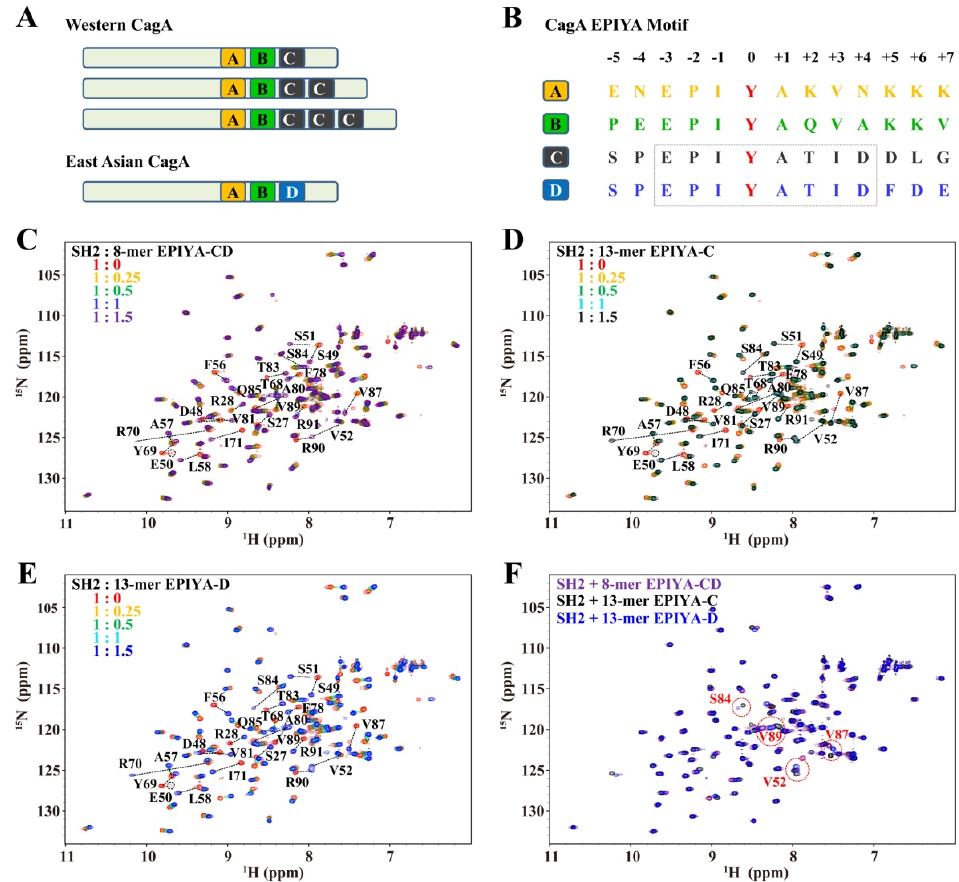
Figure 1. SHIP2-SH2 interacts with Tyr-phosphorylated CagA EPIYA-C and EPIYA-D motifs. ( A ) Domain diagrams of Western and East Asian CagA. ( B ) Amino acid sequences of four EPIYA motifs. The phosphorylated tyrosine is shown in red color. NMR titrations of SHIP2-SH2 by 8-mer Tyr-phosphorylated CagA EPIYA-CD peptide ( C ), 13-mer Tyr-phosphorylated CagA EPIYA-C peptide ( D ) and 13-mer Tyr-phosphorylated CagA EPIYA-D peptide ( E ). The residues with remarkable chemical shift perturbations are labeled in ( C – F ). ( F ) Superposed spectra of SHIP2-SH2 bound by Tyr-phosphorylated 8-mer EPIYA-CD peptide, 13-mer EPIYA-C peptide and 13-mer EPIYA-D peptide. The residues with chemical shift differences larger than 0.15 ppm are highlighted by red circles.